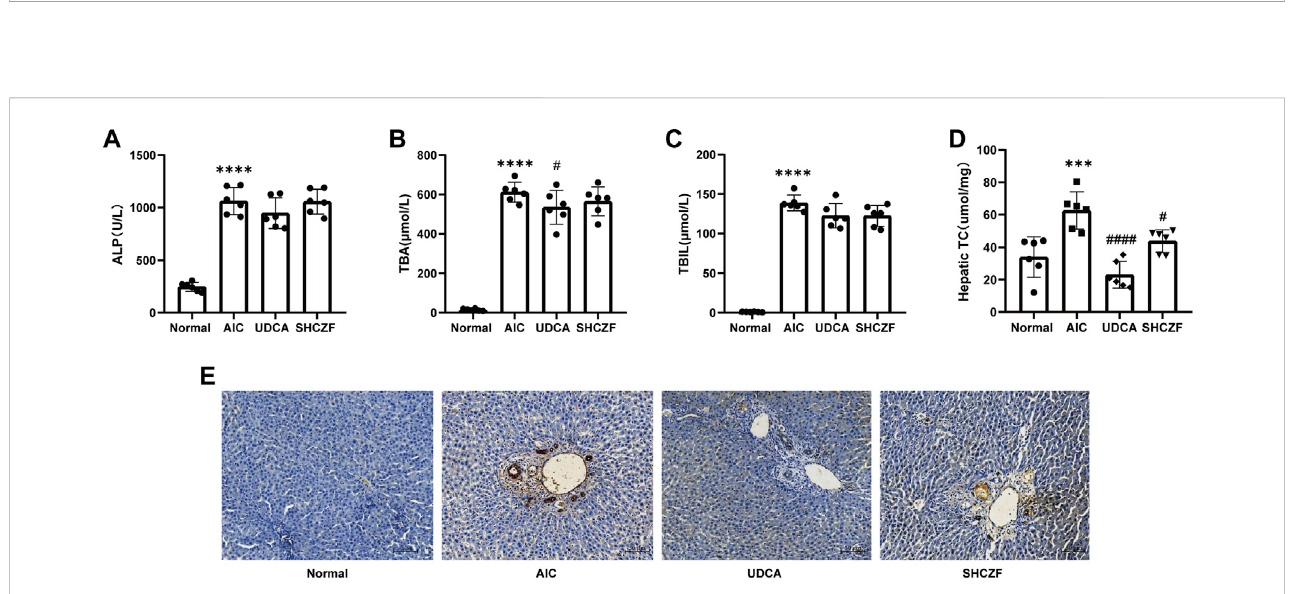
FIGURE 5 The results of cholestasis levels in rats. (A) ALP level, (B) TBA level, (C) TBIL level, (D) Hepatic cholesterol content level, (E) CK19 immunohistochemistry (400x).